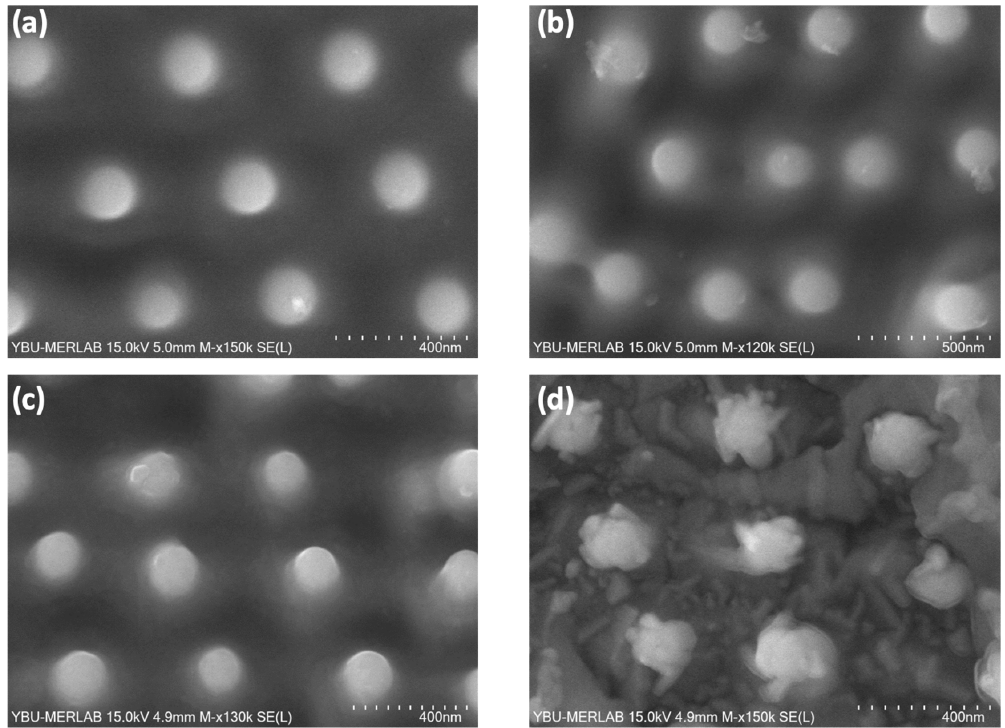
Figure 13. Top-view SEM (SE) images of the modification of the Ni5W tape surface that was laser- textured with type A3 nanostructures after additional thermal annealing treatments of 1 h in Ar atmosphere: Original surface ( a ), annealed at 523 K ( b ), 723 K ( c ) and 973 K ( d ). Electron beam acceleration voltages of 15 kV where used.